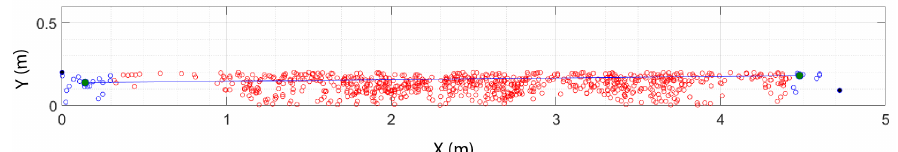
Figure 15. Fire width: distance between the mean points (filled blue circles) of the two sets of points (blue empty circles) having extreme x coordinates among the least advanced fire ground points (blue empty